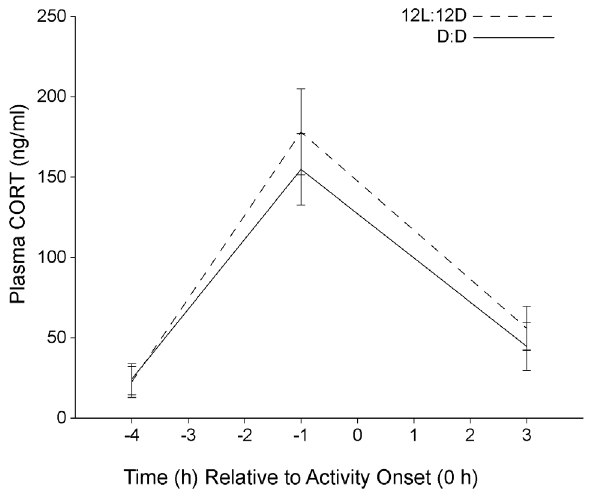
Figure 4. Plasma CORT values in wild type mice under 12L:12D and constant dark conditions. Circulating CORT values exhibited a circadian rhythm in wild type mice under constant dark (DD) conditions, with values similar to the diurnal rhythm values of plasma CORT observed under 12L:12D conditions.